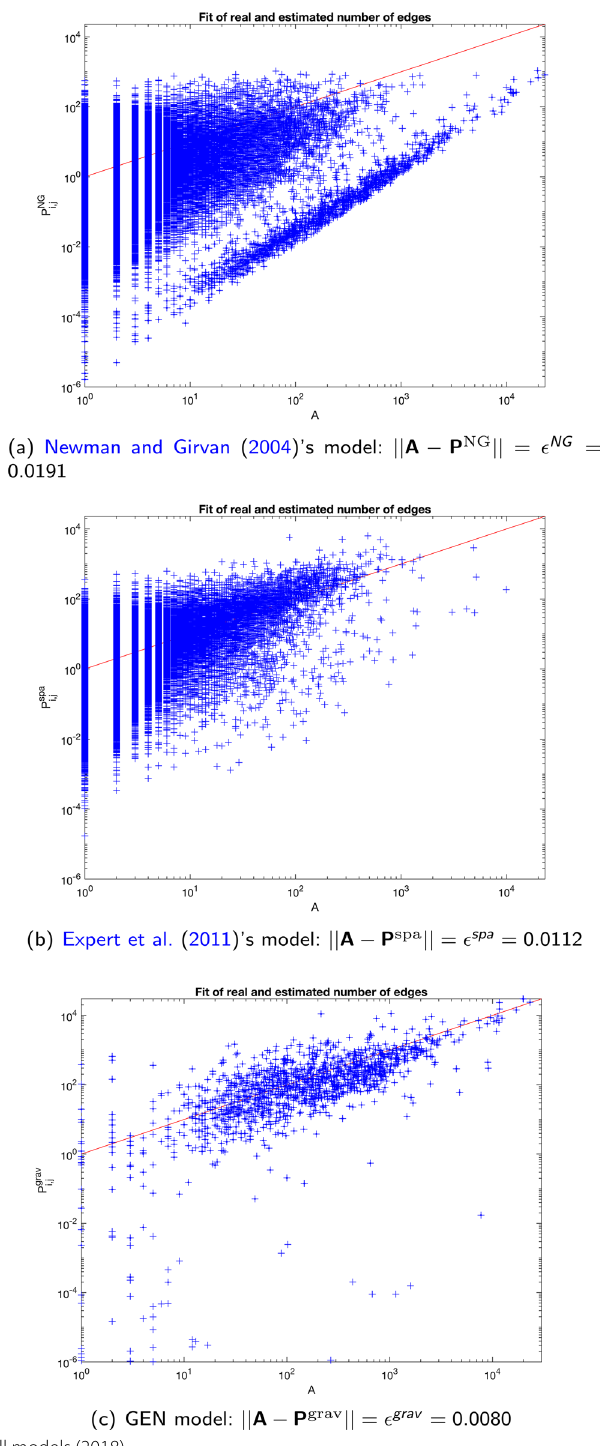
Fig. 1 Fits of null models